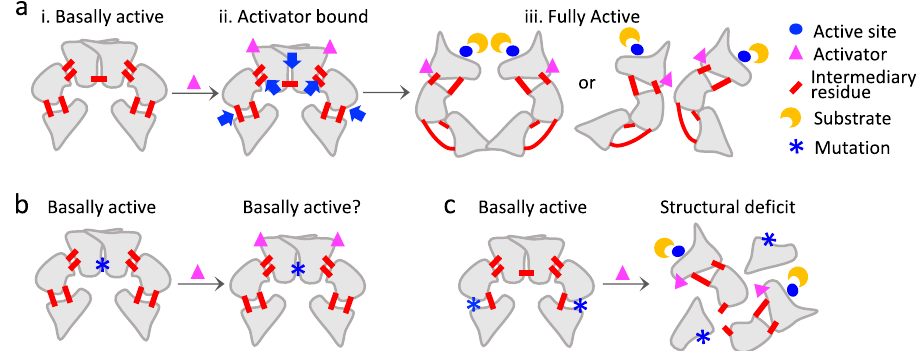
Fig. 7 Model for stress-dependent activation of ATM/ATR. a Genotoxic stress-dependent binding of an activator triggers the conformational change from a basally active dimeric enzyme complex to a fully active dimeric or monomeric enzyme. (i) The enzyme complex under unchallenged condition performs normal cellular functions. Substrate access to the active site (blue circle) is restricted to prevent inappropriate activation of the DDR. (ii) Stress induces binding of an activator (magenta triangle), which triggers the conformation transition. Some areas of the complex may experience localized strain (blue arrows). (iii) Fully active dimeric or monomeric enzyme. Intermediary residues at various locations (red bars) facilitate the enzyme activation by providing steric/mechanical fl exibility. b , c Two possible ways by which mutations at an intermediary residue might impair the DDR. b The mutation blocks the conformational transition. c The mutant complex comes apart during the transition. Note that in both cases, the mutant enzyme complex would be pro fi cient in performing its basic